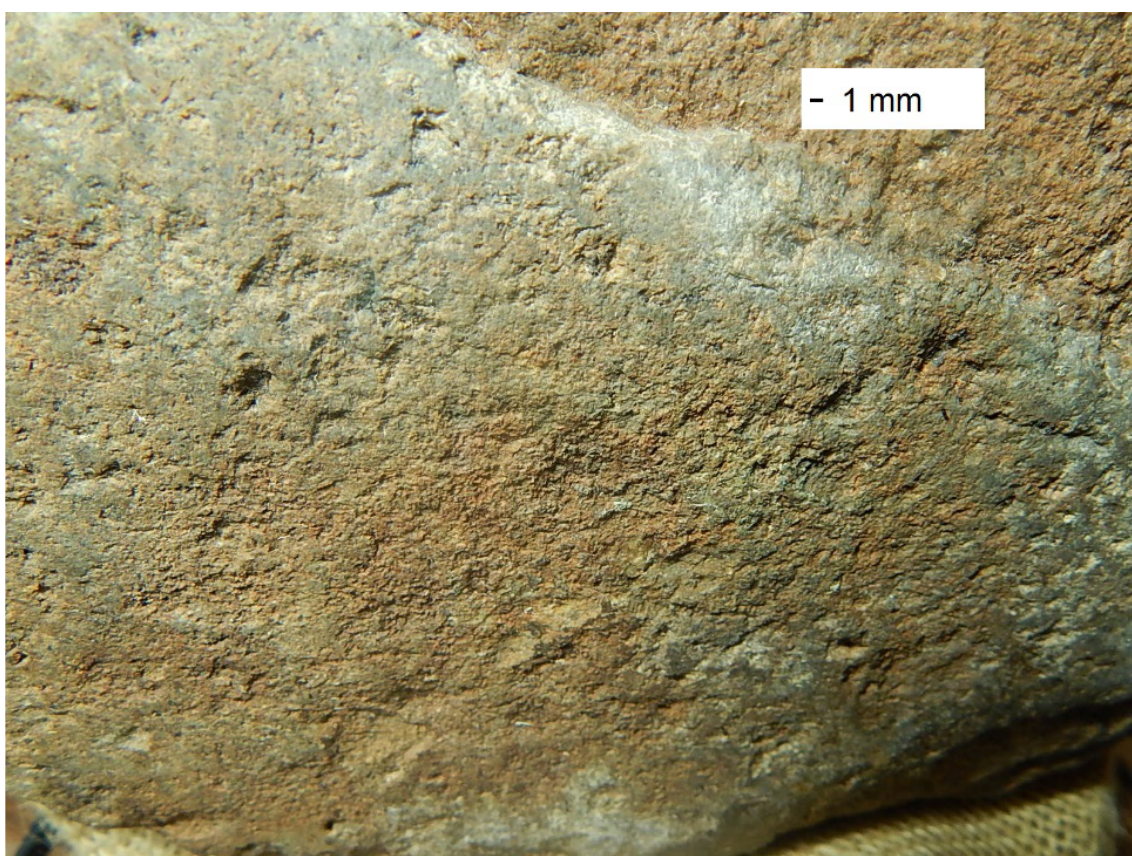
Figure 12. Specimen 5, close-up of the pecked surface. The distinct diagonal discoloration line marks portion of artifact buried (lower left), and that exposed on the ground surface (upper